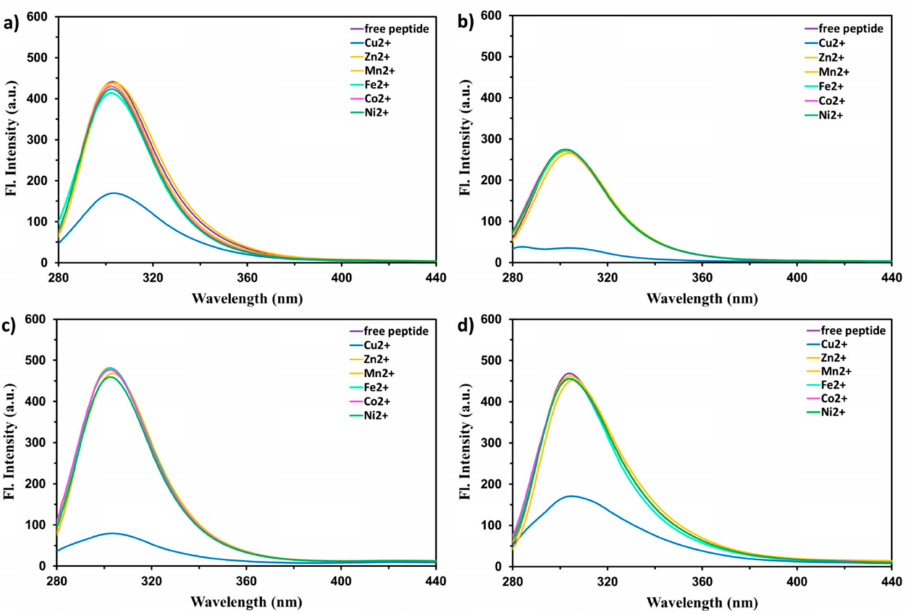
Figure 2. The fluorescence emission spectra of EYHHQ ( a ), EHYHQ ( b ), EHHQY ( c ), and KYHHE ( d ) (0.1 mM in 5 mM MES bu ff er, pH 6.0) in the absence of any ions (free peptide) as well as in the presence of Cu 2 + and other cations (80 µ M, molar ratio 1:0.8) including Mn 2 + , Fe 2 + , Co 2 + , Ni 2 + , and Zn 2 + .